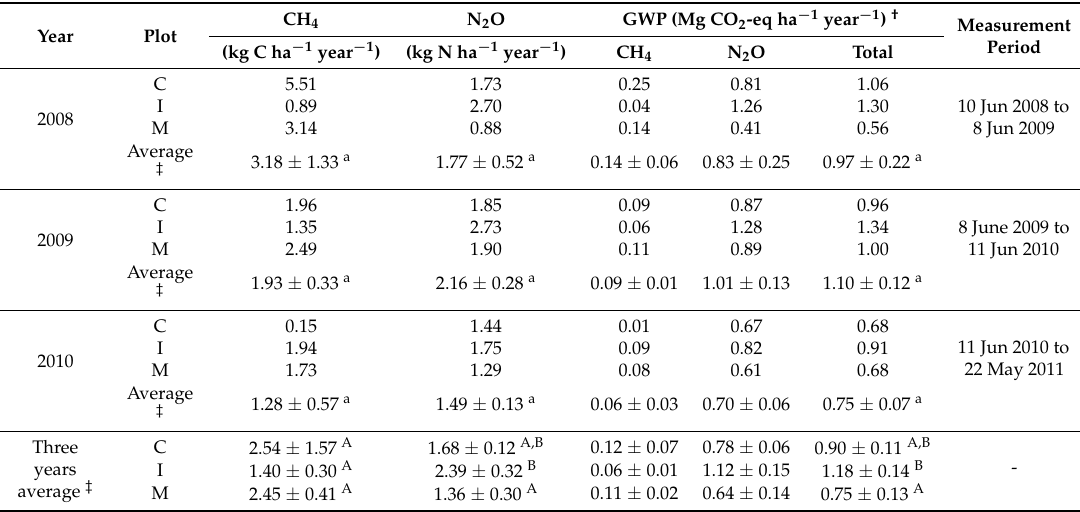
Table 1. Annual methane (CH 4 ) and nitrous oxide (N 2 O) emissions from the soybean cultivated field (upland) for three years (2008–2010).